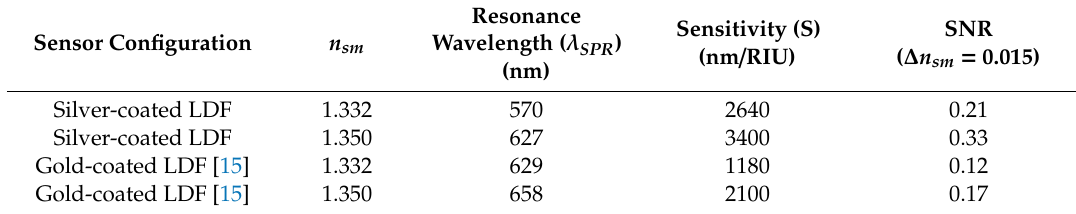
Table 1. Comparison of performances, for two refractive indices (1.332 and 1.350), of silver-coated and gold-coated SPR LDF